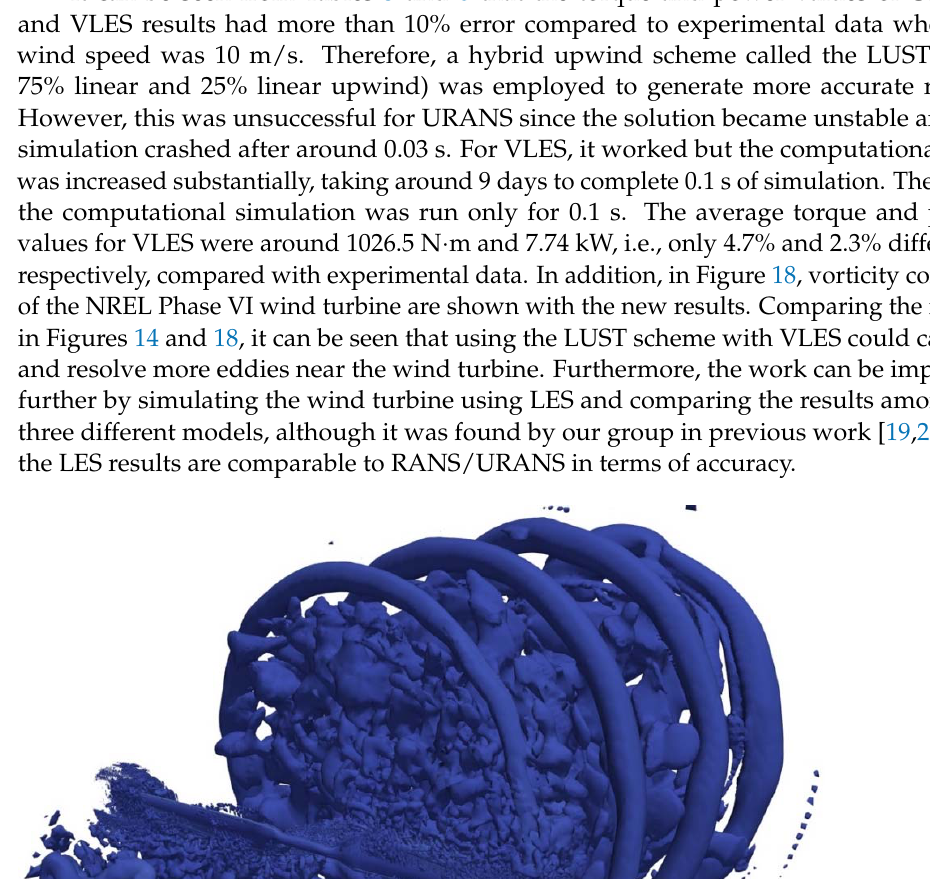
Figure 18. Vorticity contours when wind speed = 10 m/s (VLES).